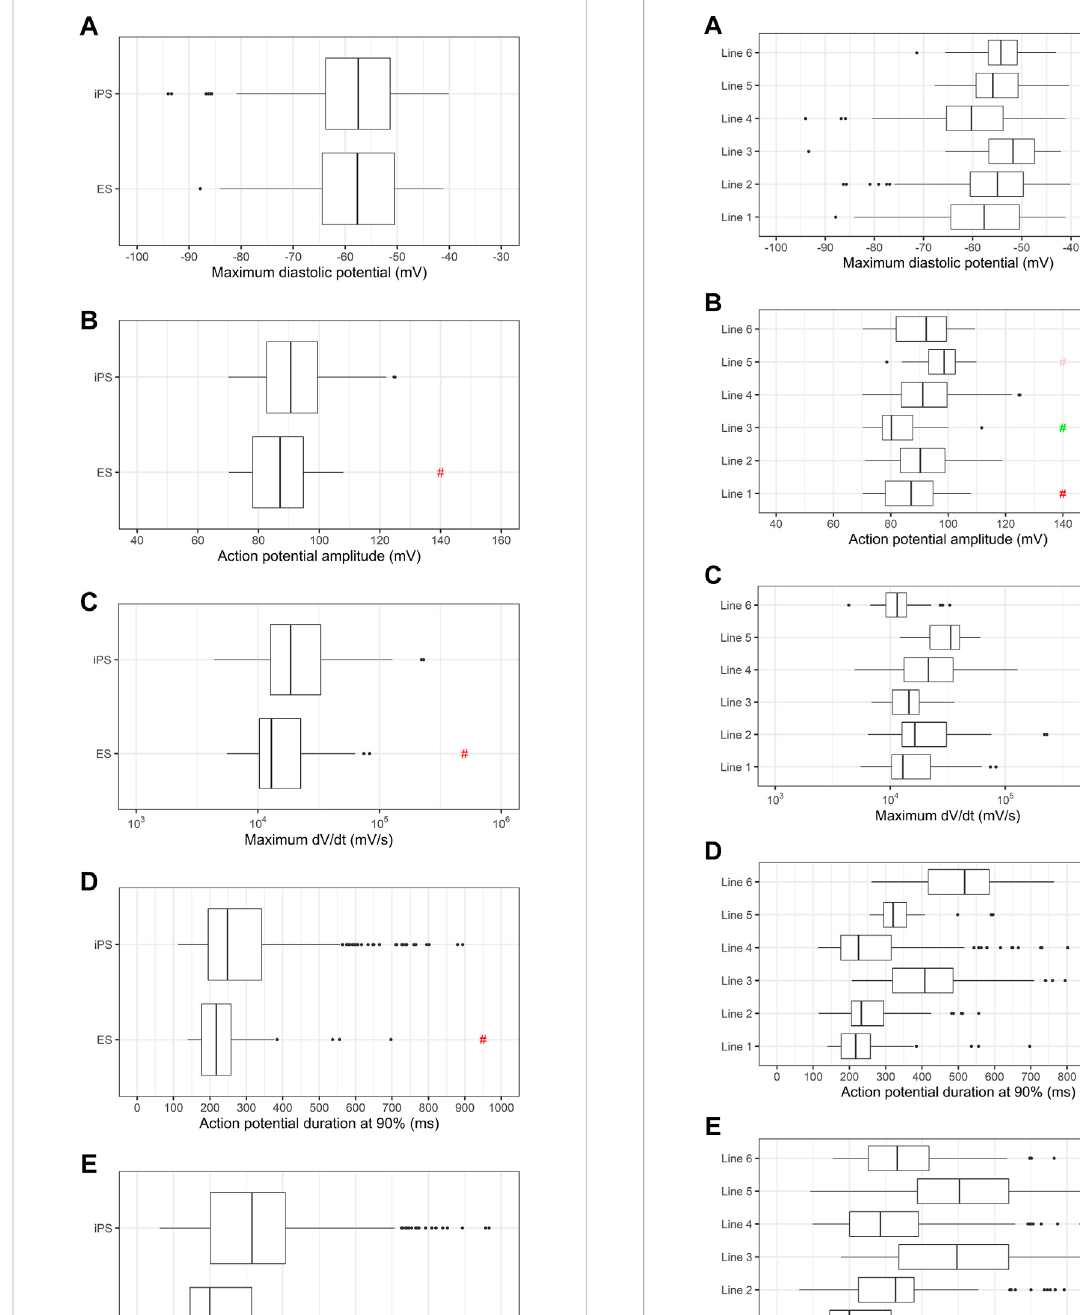
FIGURE 3 Comparison of electrophysiologic parameters of cardiomyocytes differentiated from individual cell lines. (A) Maximum diastolic potentials (MDP), (B) action potential amplitudes (APA), (C) maximumdV/dt(dV/dtmax), (D) actionpotentialdurationat90% repolarization(APD90)and (E) cyclelengthareshown.#indicates p < 0.05 using one-way ANOVA followed by Tukey ’ s post test. Signi fi cant differenceswereobservedinthefollowingparameters:MDP(red:1vs. 3,orange:4vs.2,3and6),APA(red:1vs.2,4and5,green:3vs.2,4,5 and6,pink:5vs.1,2and3),dV/dtmax(red:1vs.2,4and5,green:3vs. 2,4and5,purple:6vs.2,4and5),APD90(red:1vs.3,5and6,blue:2